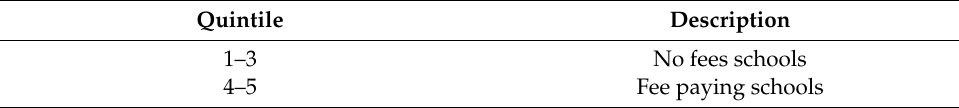
Table 1. Background to South African quintile system.